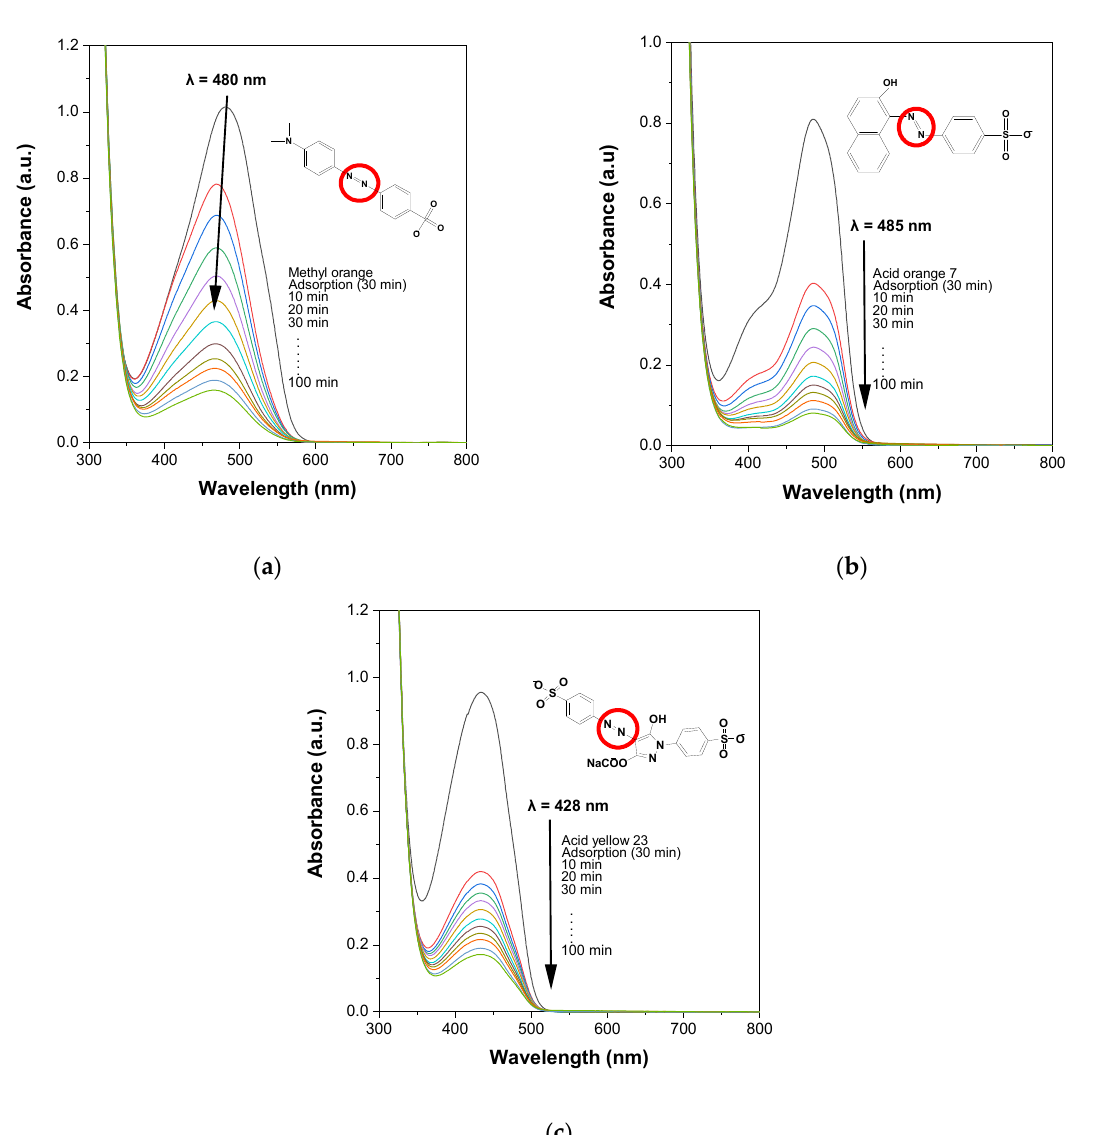
Figure 6. UV-vis absorption spectra of photocatalytic degradation of the azo dyes ( a ) MO, ( b ) AO7, and ( c ) AY23 by the Gd 2 O 3 /H 2 O 2 /UV method for 100 min. (Experimental conditions: initial dye concentration: 0.042 mM; photocatalyst concentration: 1.0 g/L; H 2 O 2 concentration: 4.8M; wavelength of UV irradiation: 254 nm).